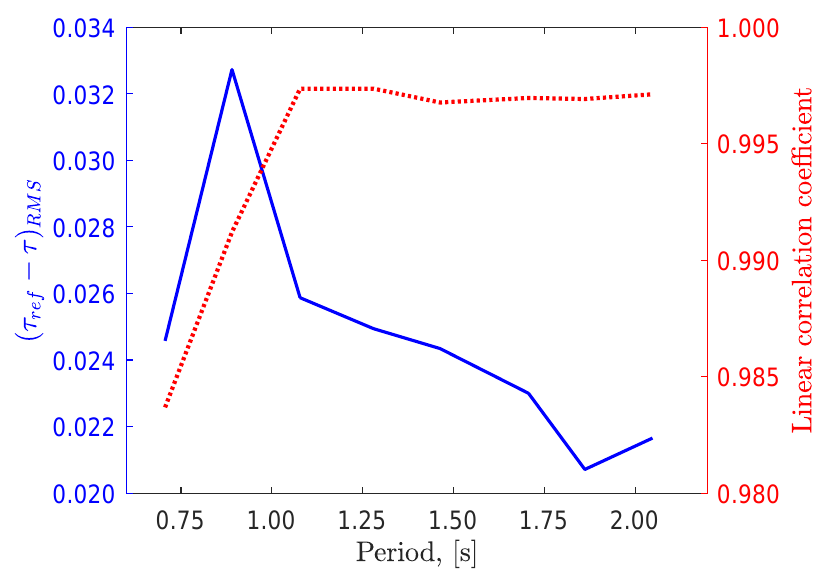
Figure 10. Frequency dependency of the actuator reference following capability in terms of the root-mean-square (RMS) of ( τ ref − τ ) and in terms of linear correlation coefficient between τ ref and τ , for Setup 3. Note that the wave period has been chosen as the x-axis to better relate to the different regular waves used during the experimental